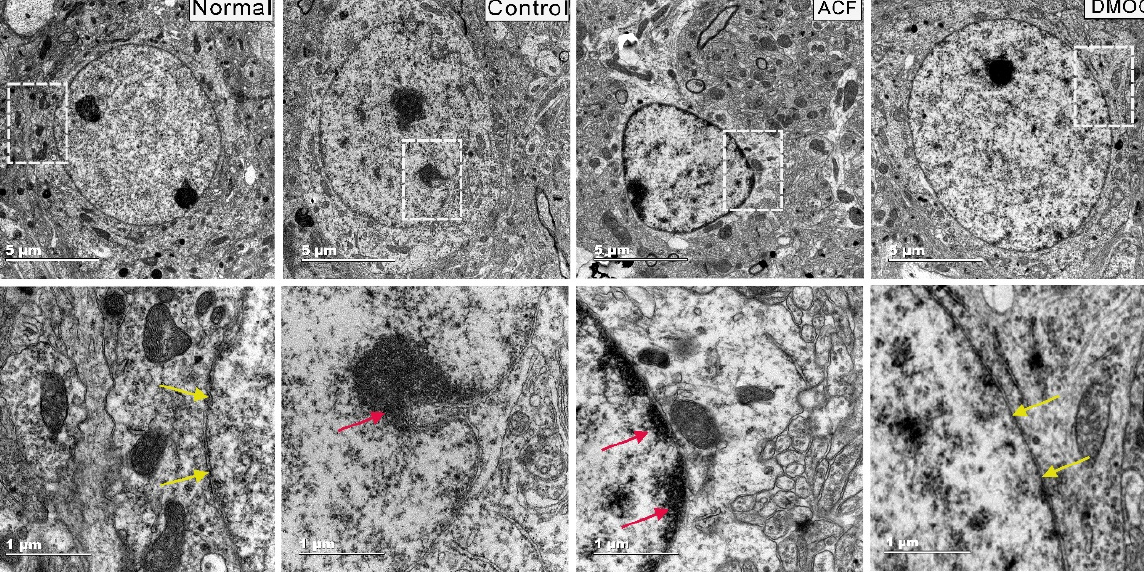
Figure 6. HIF-1 α activation alleviates brain damage via protecting the neuronal soma. Representative images of transmission electron microscopy [TEM] [magnification × 24,000]. The ultrastructure of the neuronal soma 7 days post-ischemia, yellow arrow points to the nuclear membrane which shows no alteration in case of DMOG, ACF and Control groups show a significant alteration in the neuronal soma structure when compared with the normal mice. Scale bar: 5 µ m and 1 µ m, n =